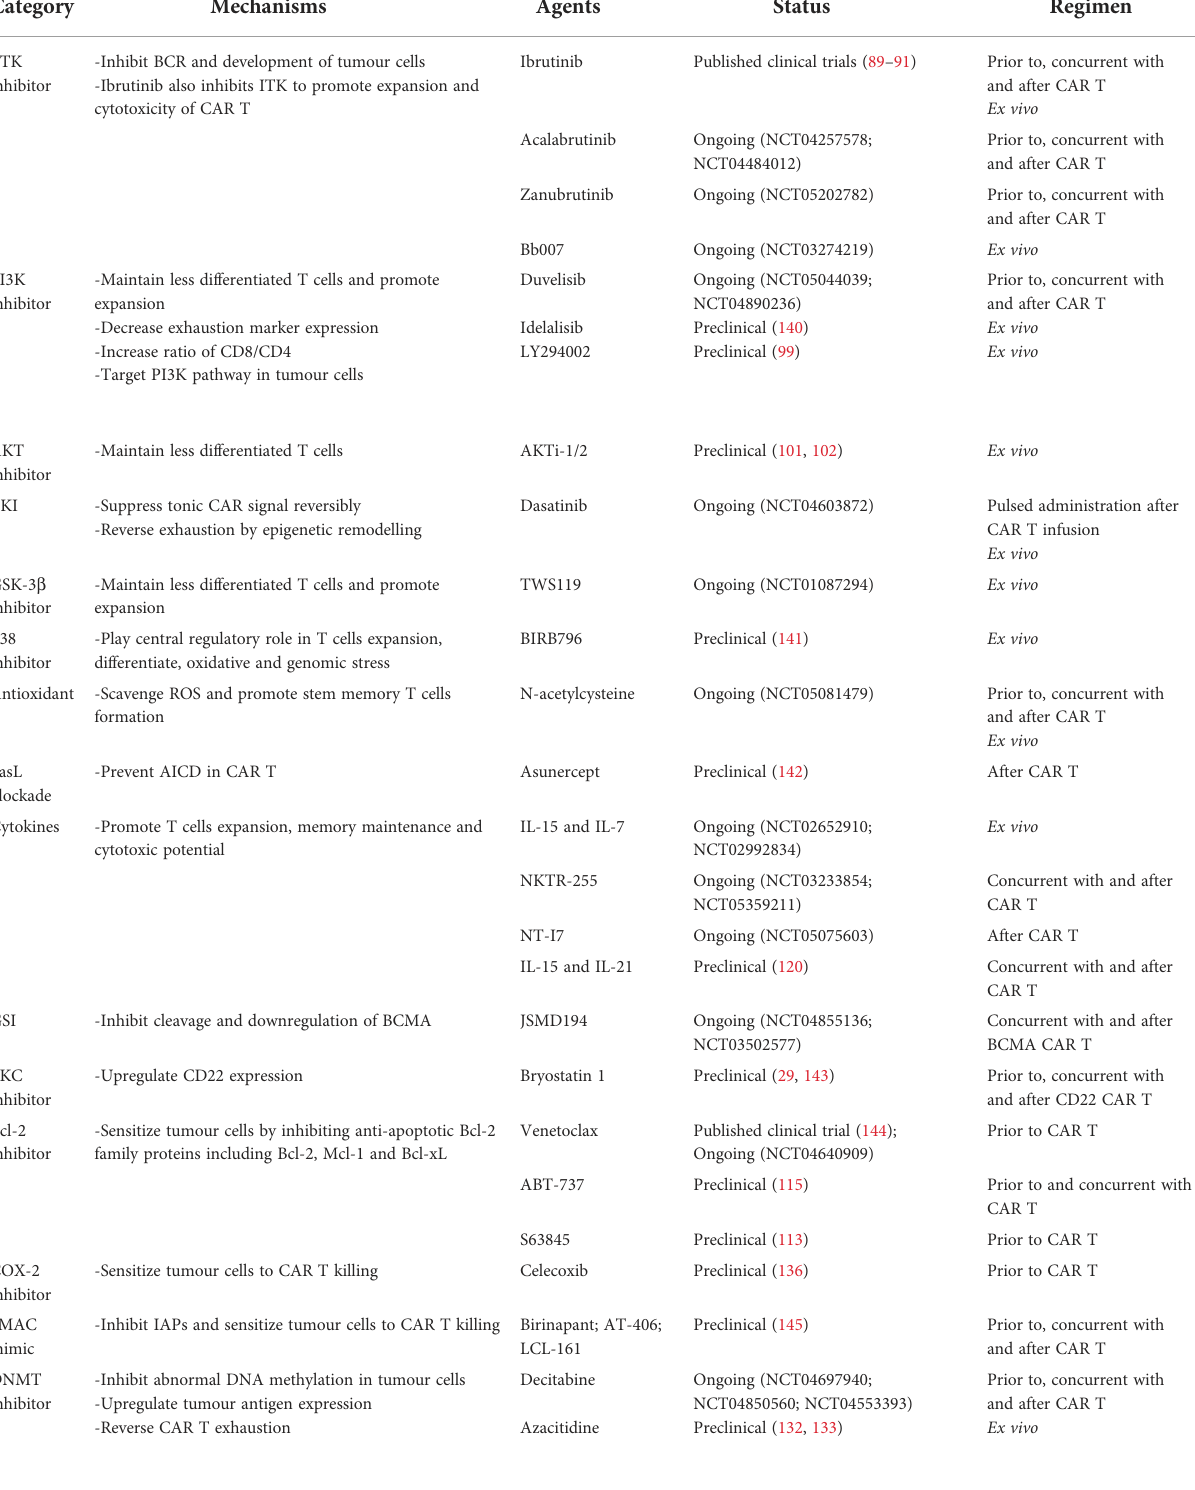
TABLE 3 Rationales for the combination of CAR T cell therapy with targeted therapies and other immunotherapies.